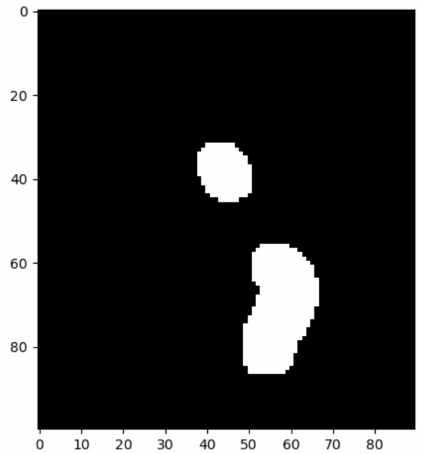
Figure 13. Binary image of the Aortic Valve (region of interest) where our algorithm found two areas with